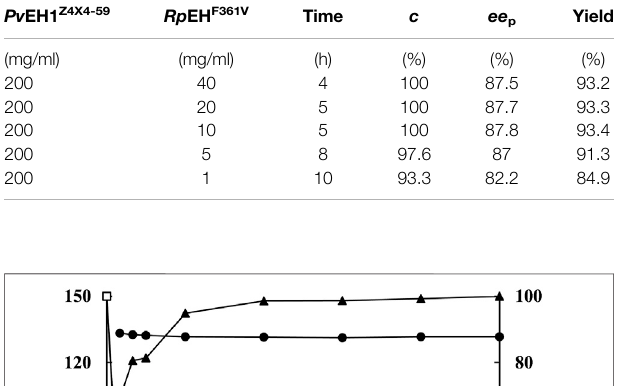
Frontiers in Bioengineering and Biotechnology |